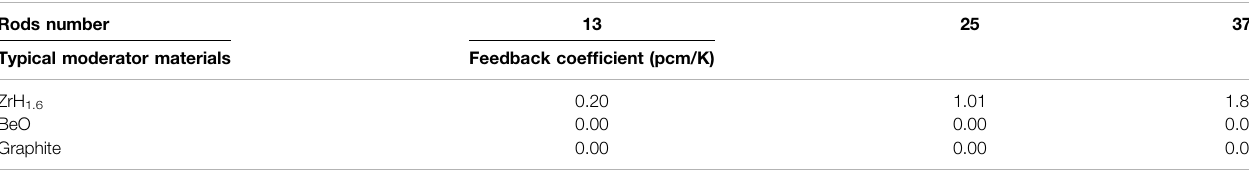
TABLE 8 | Moderator temperature feedback coef fi cient with different number of moderating rods.